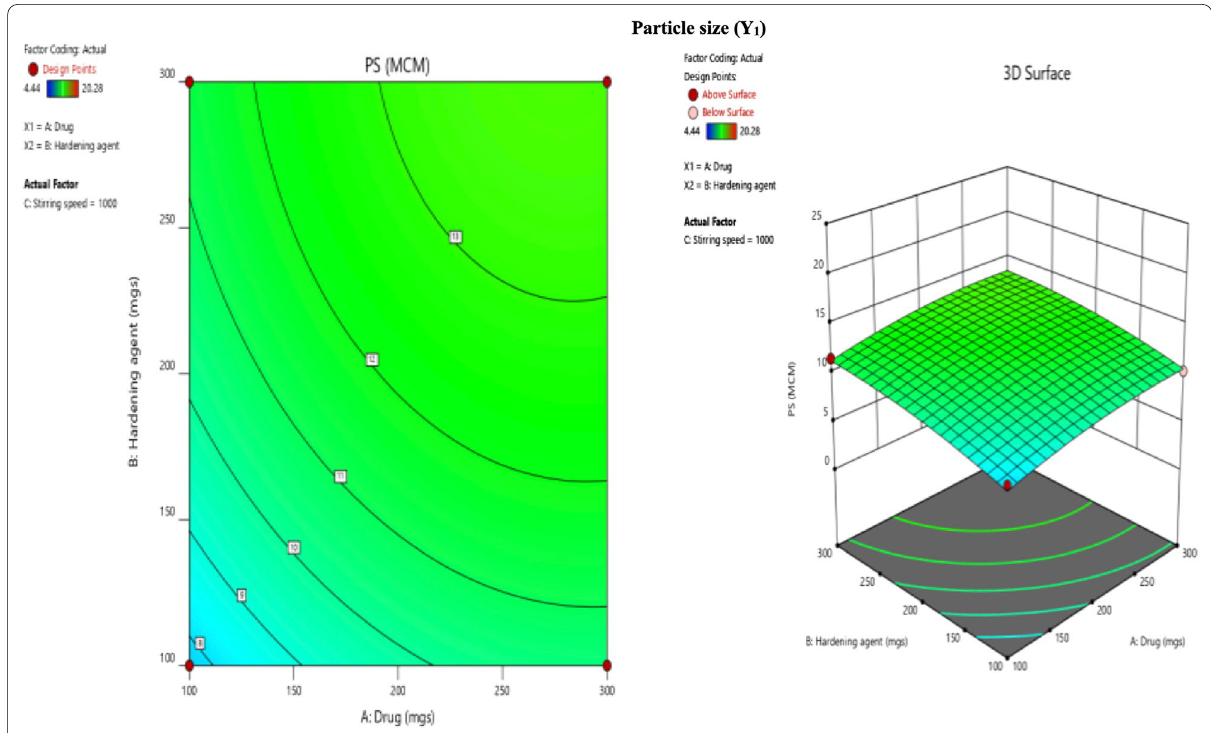
Fig. 1 Contour plot and response surface plot for particle size ( Y 1